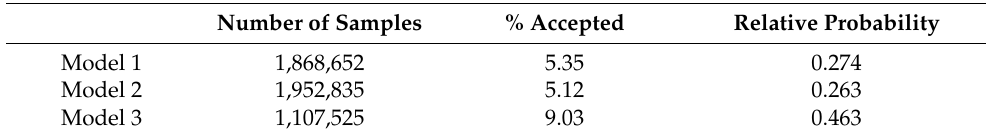
Table 7. Table with number of sample parameter sets required for 10 5 sets to be accepted. An Euclidean distance measure was used with ε = 3 as threshold value for acceptance. Percentage of accepted parameter sets also